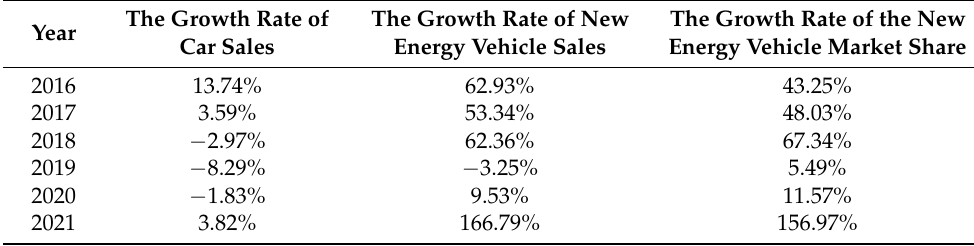
Table 4. Year-on-Year Growth Rates for Automobile-Related